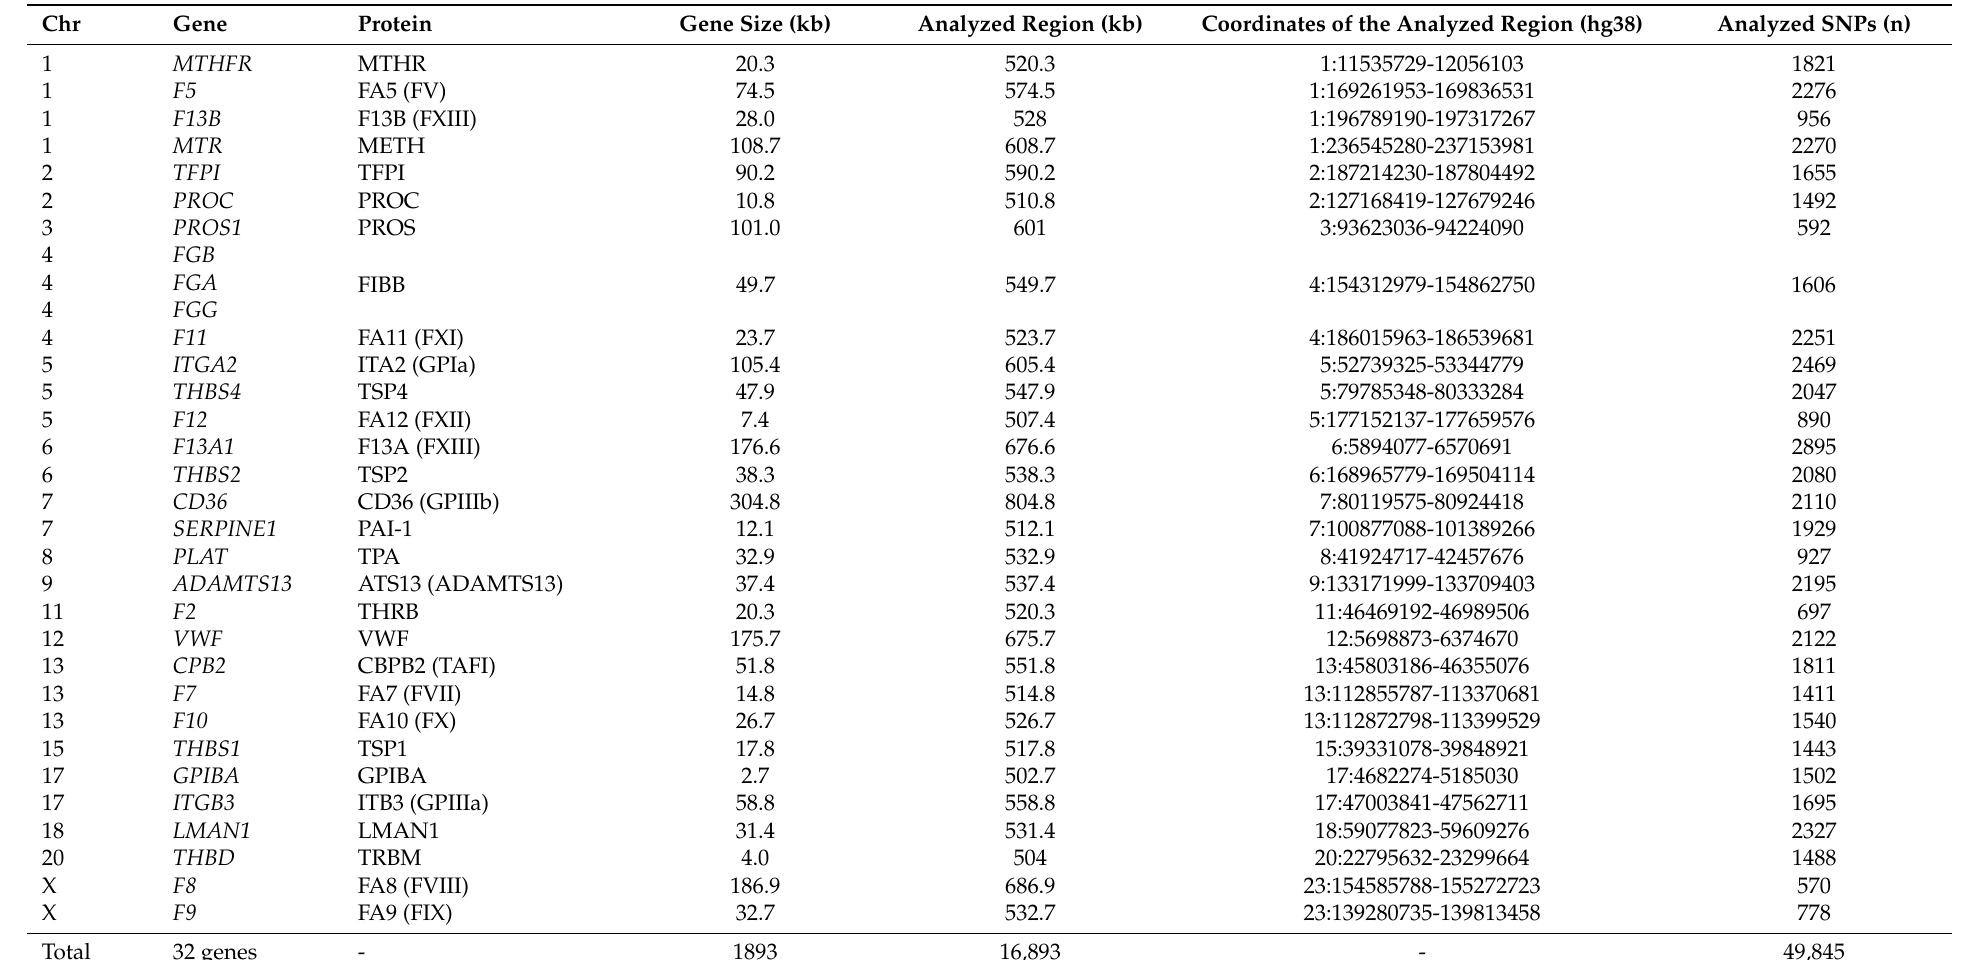
Table 1. Hemostatic gene loci tested for association with severe